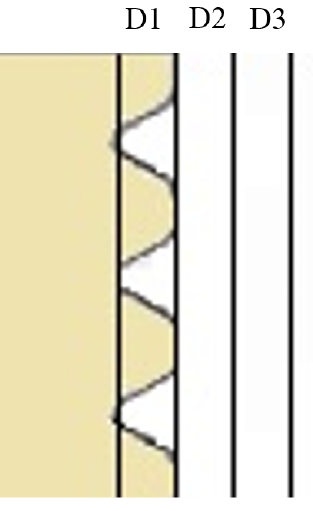
Figure 4. Schematic plan of the subdivision of micro-CT volume of interest (VOI). D1 is the closest to the threads and D3 is the one furthest away.